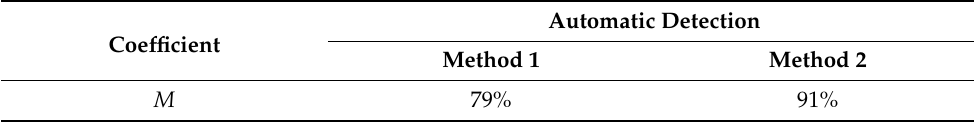
Table 6. Obtained average values of the M